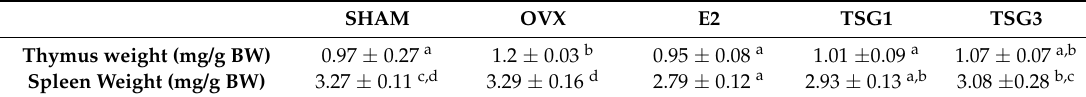
Table 1. The effect of 2,3,5,4 ′ -tetrahydroxystilbene-2- O - β - D -glucoside (TSG) on the thymus and spleen weight in ovariectomized (OVX) mice.